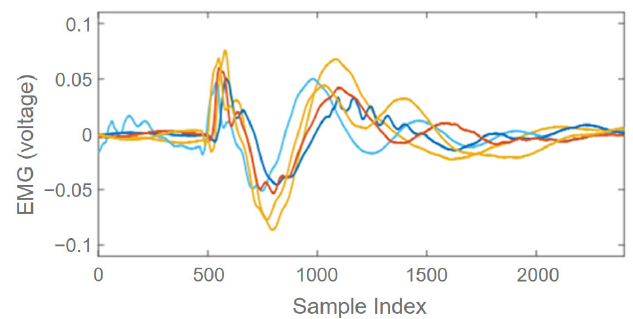
Figure 3. Raw EMG signals from five subjects performing the exercise in the pre ‐ experiment.